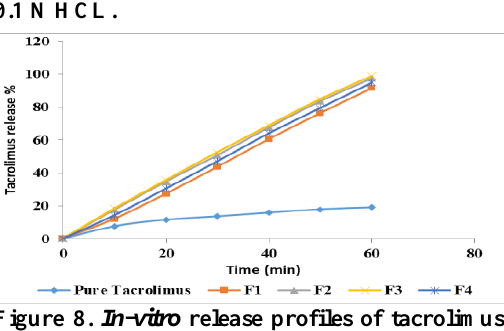
Figure 8. In-vitro release profiles of tacrolimus- loaded SMEDDS formulae compared with pure